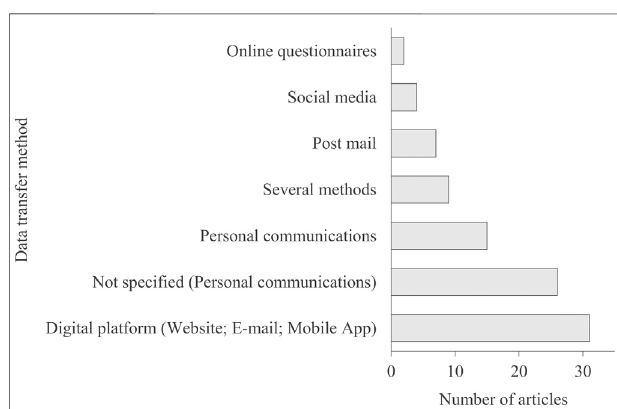
FIGURE 5 | Number of articles published on citizen science and non- indigenous species according to the method used by citizen scientists to transfer data to scientists. A total of 94 articles reported information on this issue. Articles based on citizen science databases and evaluations of citizen science projects (n (cid:1) 32) were not included in this fi gure because data were not gathered throughout the process of the speci fi c study. Data